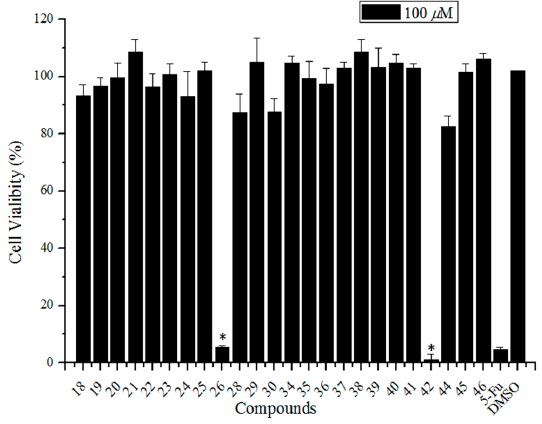
Figure 2. The cytotoxicity screening of sialic acid and pentacyclic triterpene conjugates (100 μ M) using CellTiter-Glo ® Assay. DMSO and 5-Fu were used as negative and positive controls, respectively. Error bars indicate standard deviations of triplicate experiments. * compared with negative control, p < 0.05.